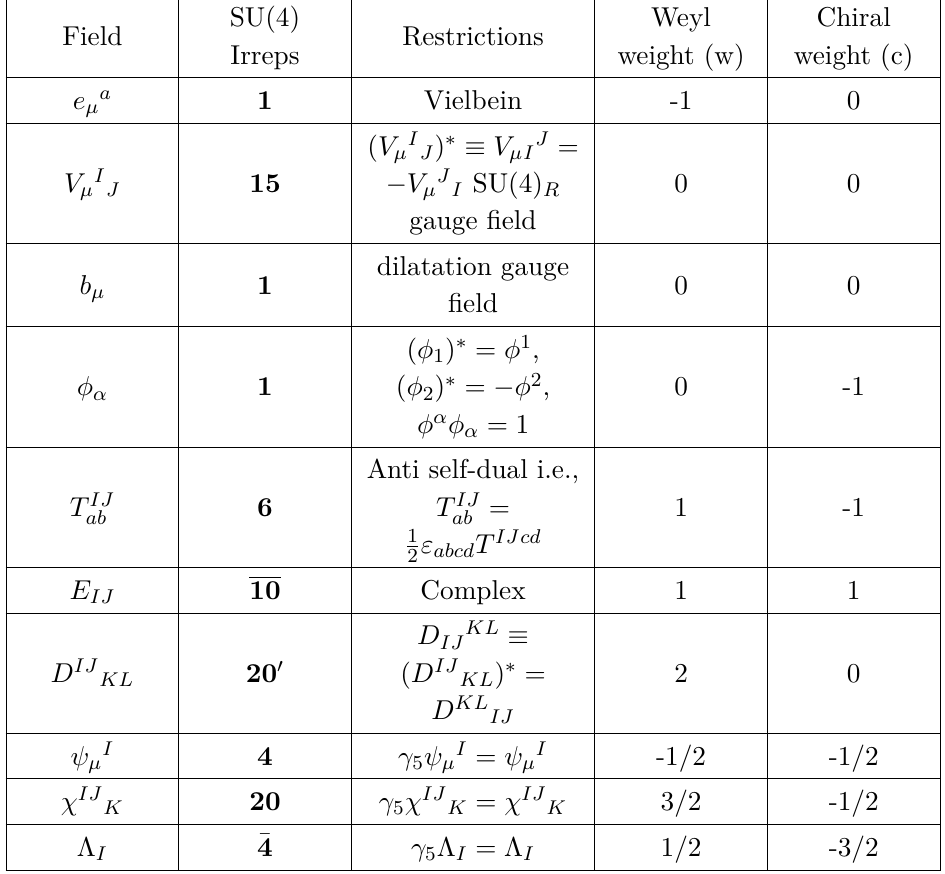
Table 2 . Independent fields of the N = 4 Weyl